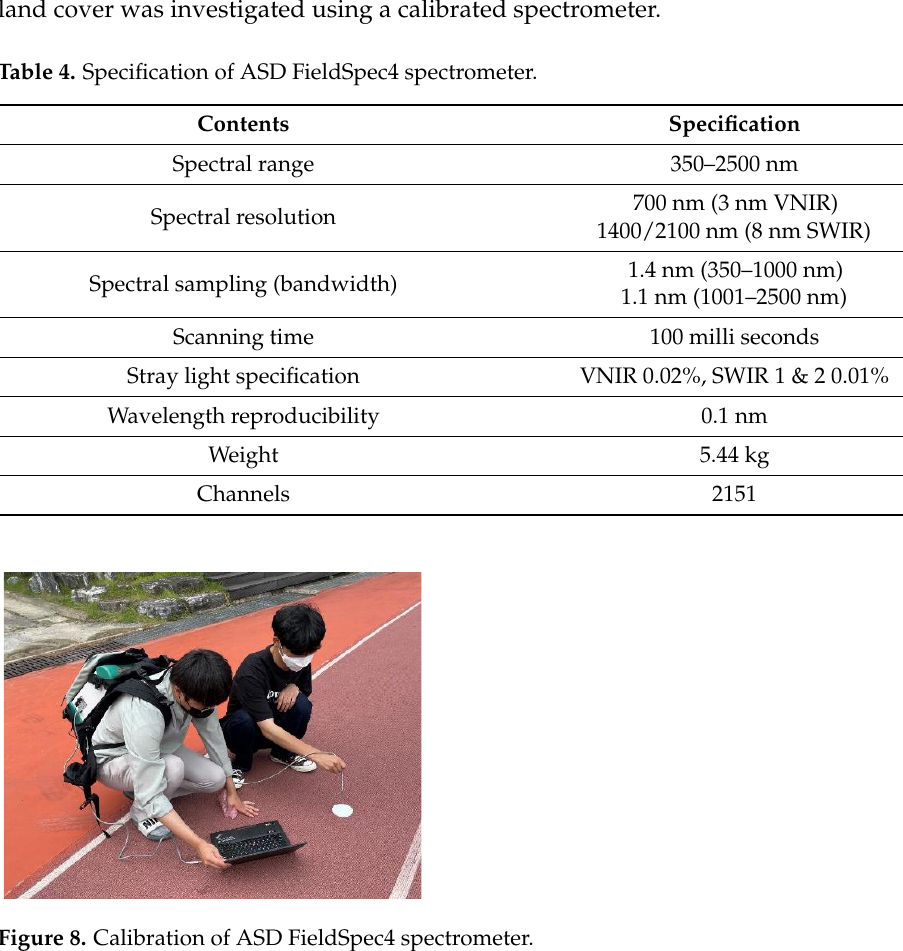
Figure 7. Orthoimage results for each camera image.